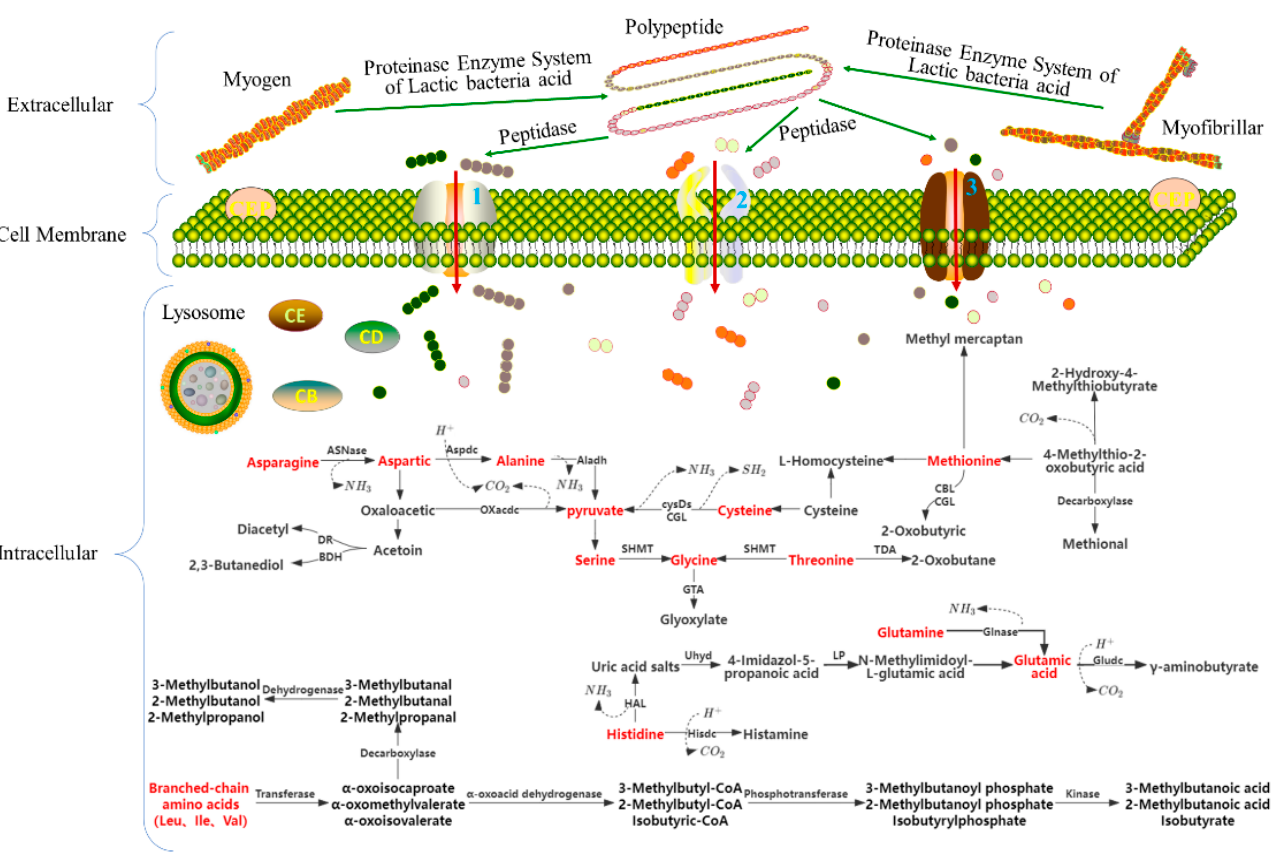
Figure 1. Metabolism of fermented meat products through lactic acid bacteria and the flavor of the substances produced. 1: Oligopeptide transport channels; 2: Small peptide transport channels; 3: